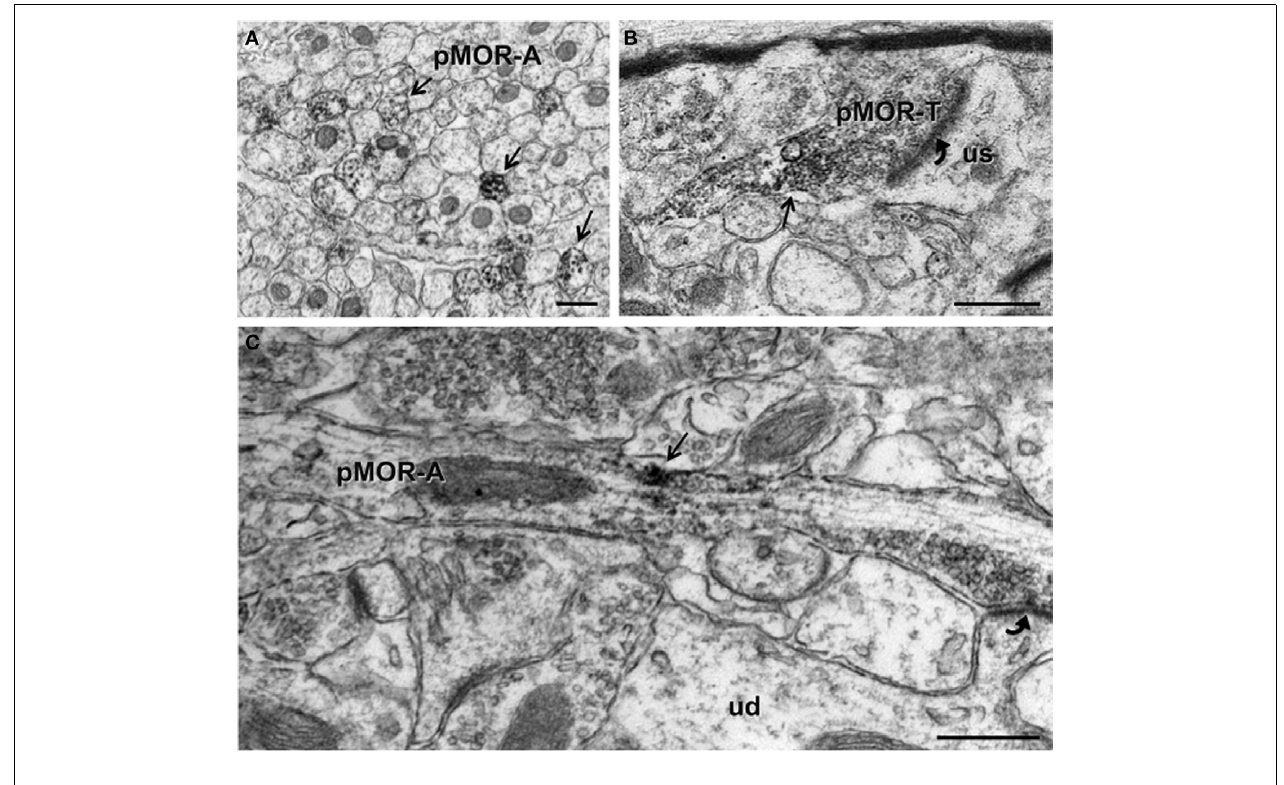
asymmetric synapse (curved arrow) with an unlabeled dendritic spine (us). (C) pMOR-ir is affiliated with small synaptic vesicles in an enpassant axon that forms an asymmetric synapse (curved arrow) with a dendritic spine emanating from an unlabeled dendritic shaft (ud). Scale bar =